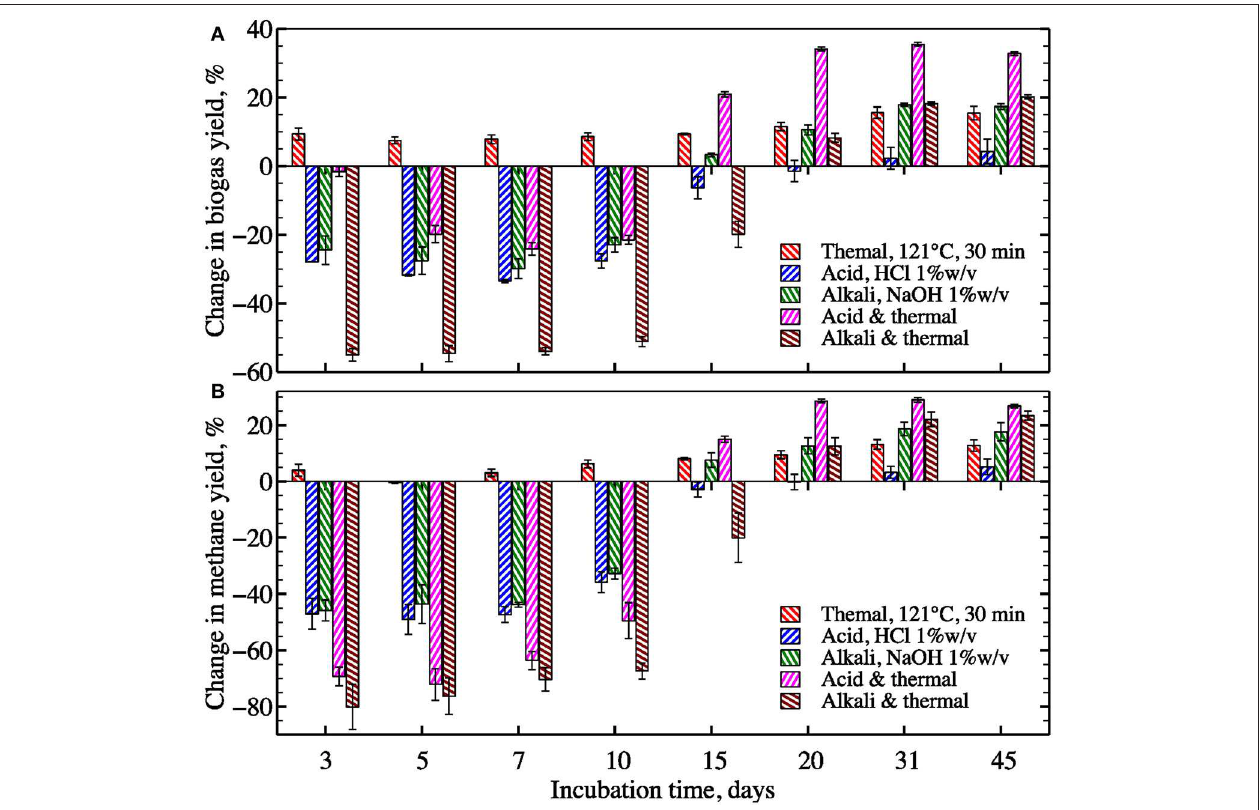
FIGURE 6 | Impact of pretreatment on biogas (A) and methane (B) yields compared to untreated algae at different incubation periods (error bars 1 S.D. for three replicates).